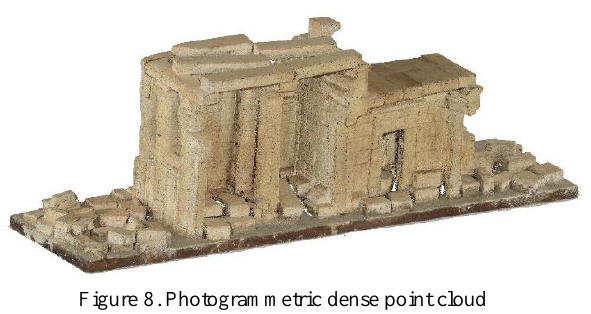
Figure 7. Image of the model of the Temple of El-Hilla (top) and the same image after the masking process (bottom)